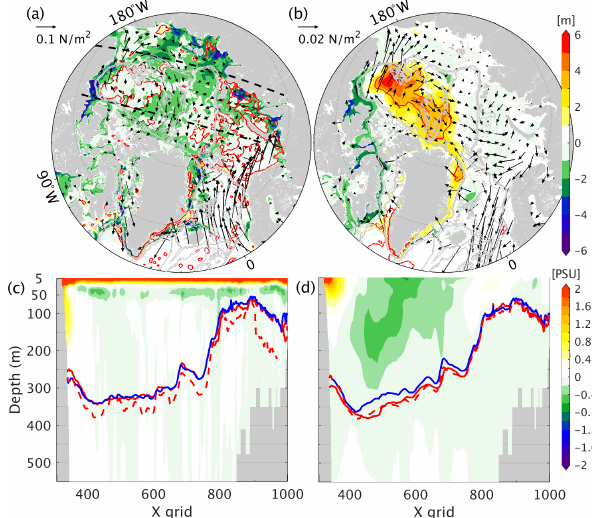
Figure 12. The differences of freshwater inventory in meters (shad- ing), sea level anomaly (0.15m contour, black lines), and wind stress (vectors) between (a) February 2003 and September 2002, and (b) 2008–2010 and 1994–1996. Panels (c) and (d) are the cor- responding salinity differences (shading) average over the central Arctic Ocean (dashed black lines in panel a ). The blue lines denote the 27.9kgm − 3 isopycnal in September 2002 and 1994–1996, re- spectively. The red lines and dashed red lines are the 27.9kgm − 3 isopycnal and the diagnosed 27.9kgm − 3 isopycnal with SLA and Eq. (5) in February 2003 and 2008–2010,